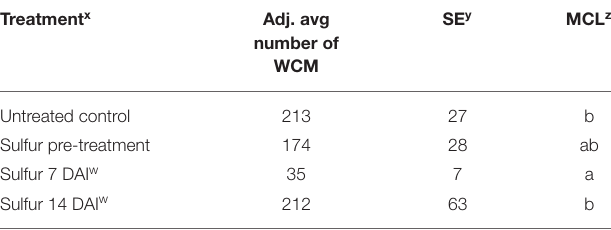
TABLE 6 | Effect of sulfur application timing on average WCM total per plant. Treatment x